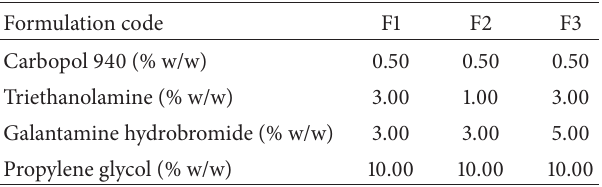
Table 3: Three gel formulations with the highest percentage of drug release.